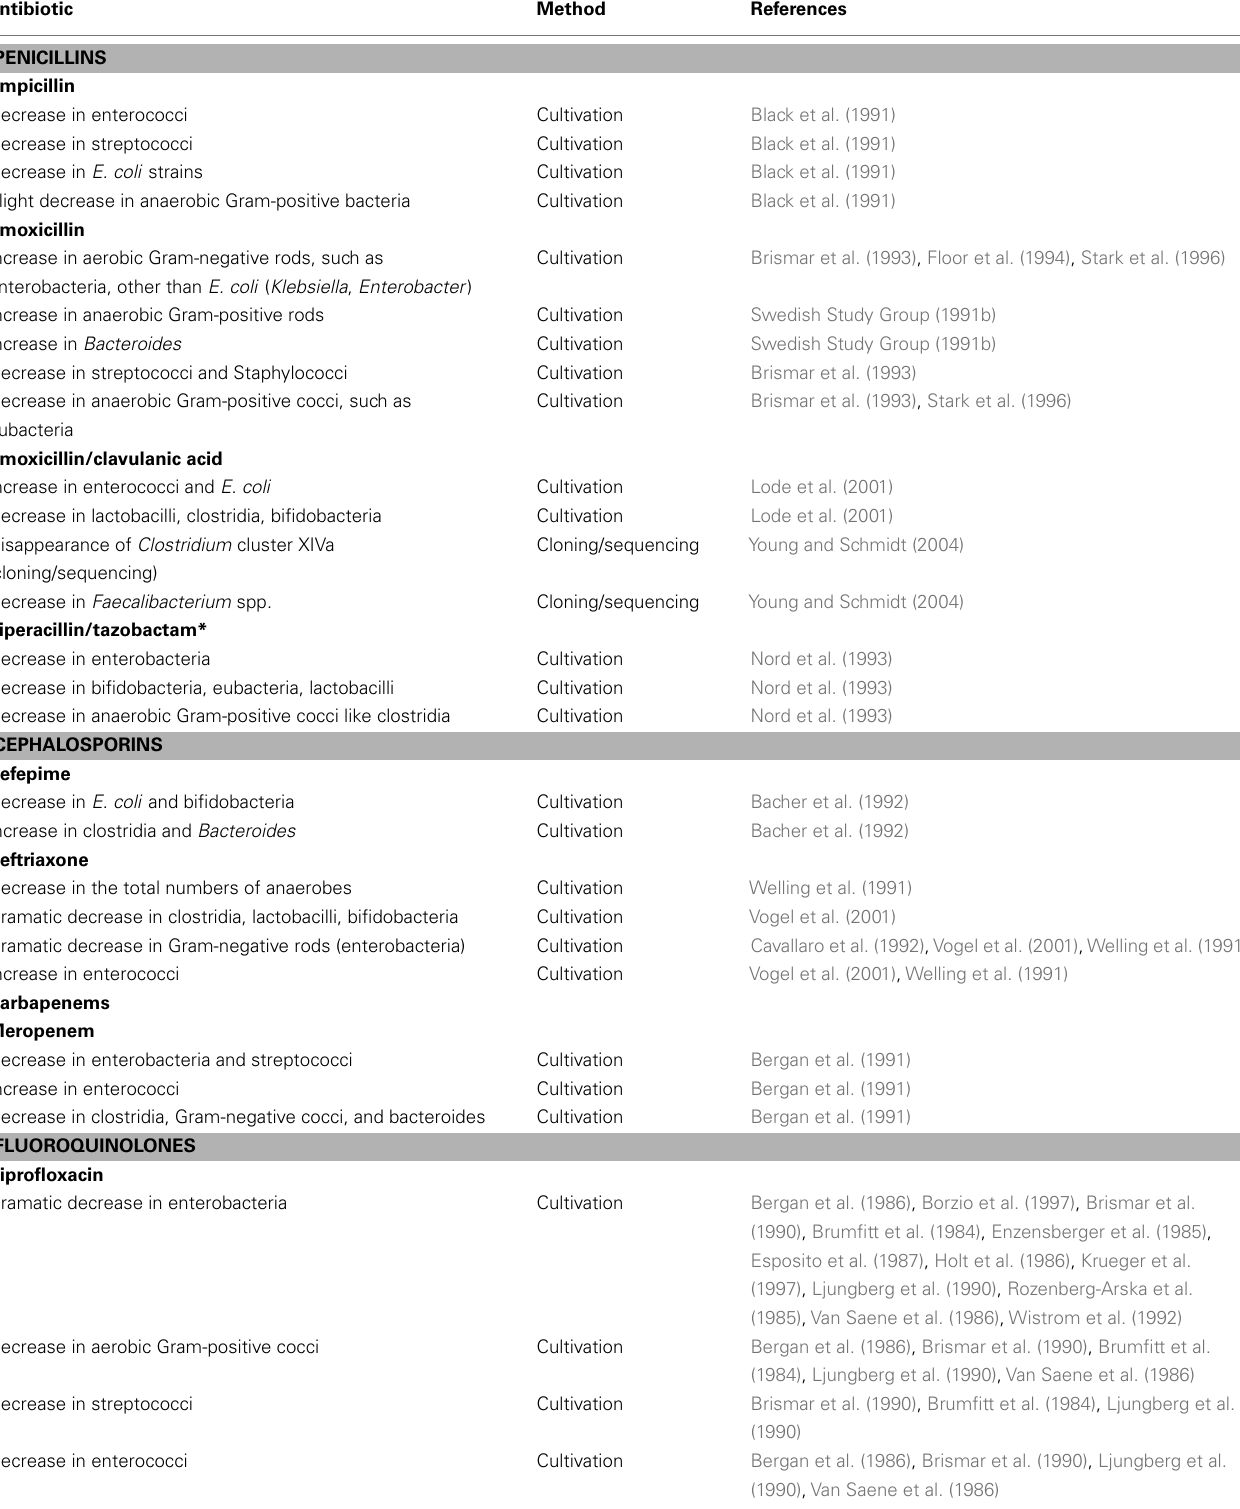
Table 1 | Modifications of gut flora linked to